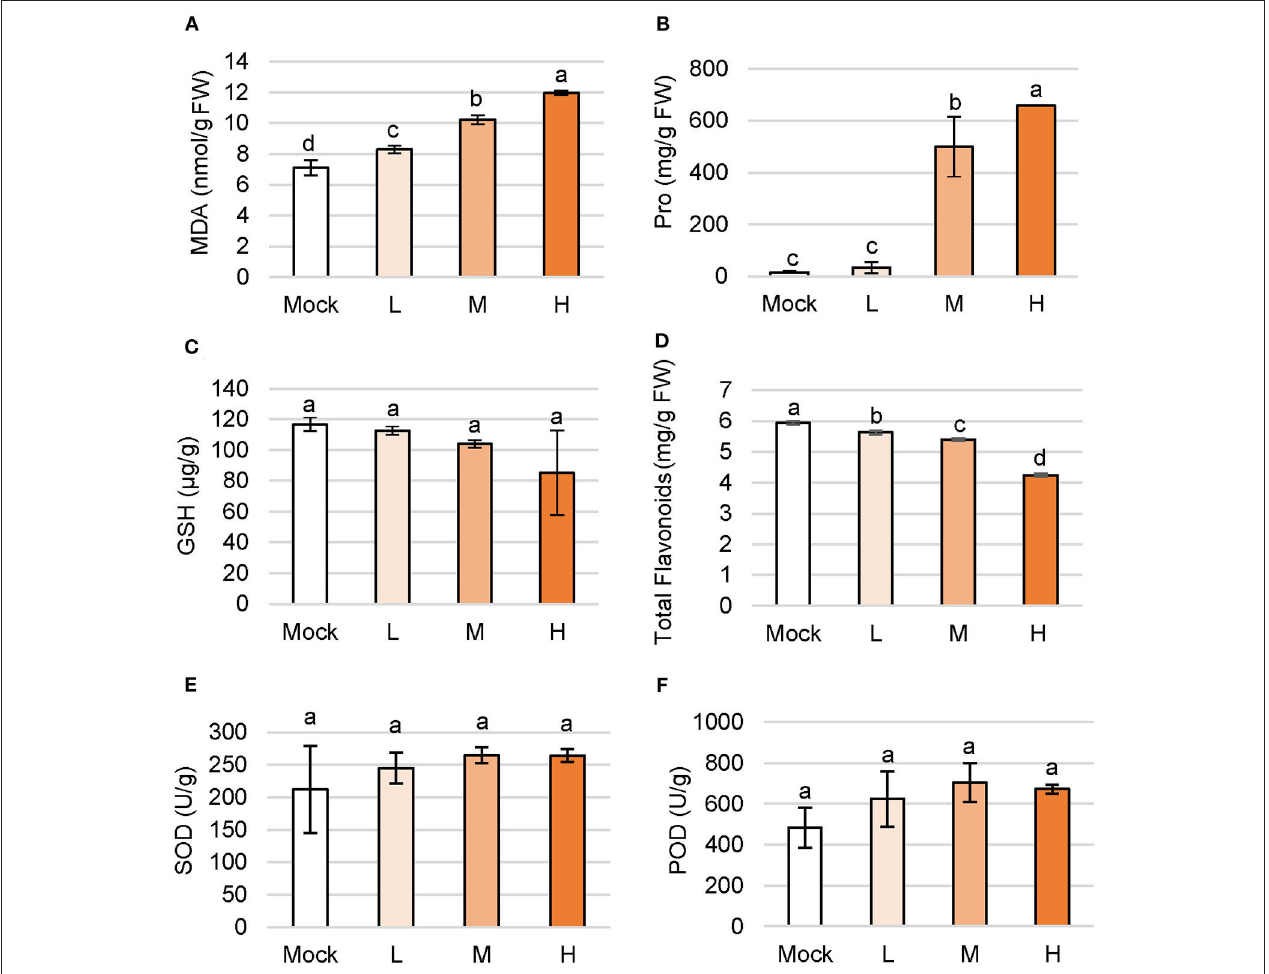
FIGURE 2 | Changes of primary and secondary metabolites in C. inerme under salinity stress. Content of MDA (A) , proline (B) , GSH (C) , total flavonoids (D) , SOD (E) and POD (F) in plant leaves on day 14 under salt adversity. Different letters indicate significant differences among plant groups ( p < 0.05, Mann Whitney test). Mock, no salt control; L, low salt stress; M, medium salt stress; H, high salt